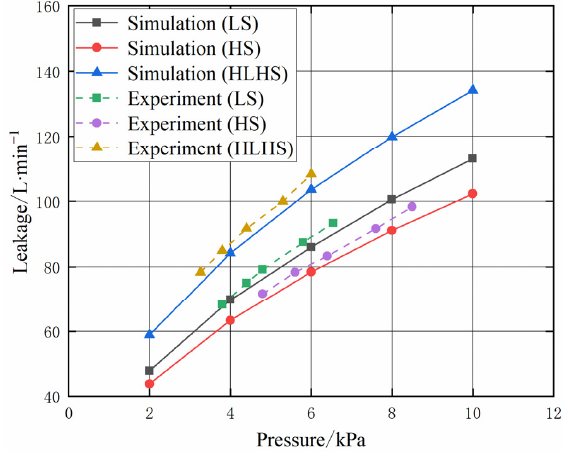
Figure 15. Comparison of numerical simulation and experimental results of three types of seals (RE = 0 mm).